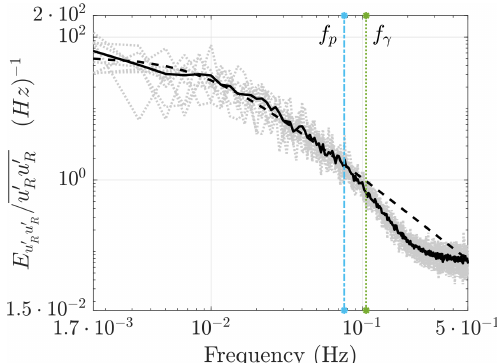
Figure 9. 1D frequency dependent spectra for Case 02b. Observations of 10-min spectra in light grey, the 3-h average in black full lines, and the ESDU reference in black dashed